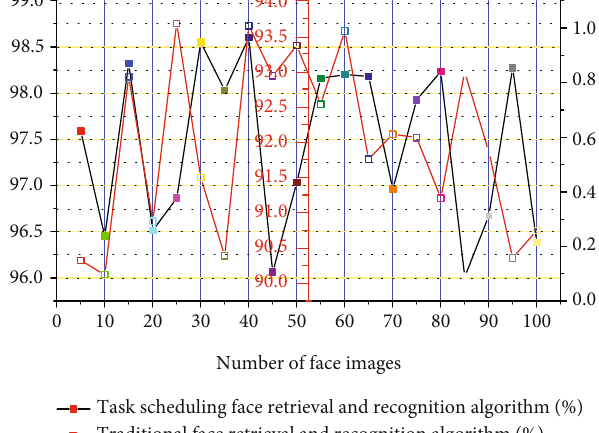
Figure 7: System recognition